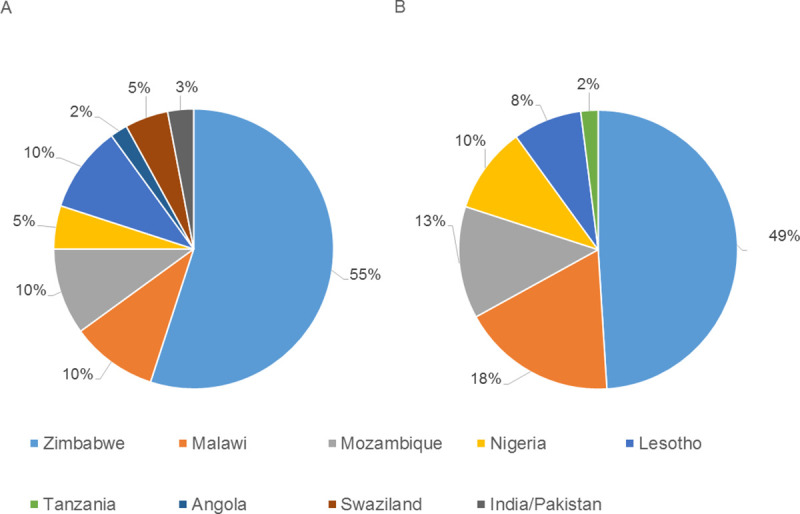
Countries of origin of foreign parents/caregivers.(A) Neonatal group (n = 60). (B) General paediatric group (n = 61).